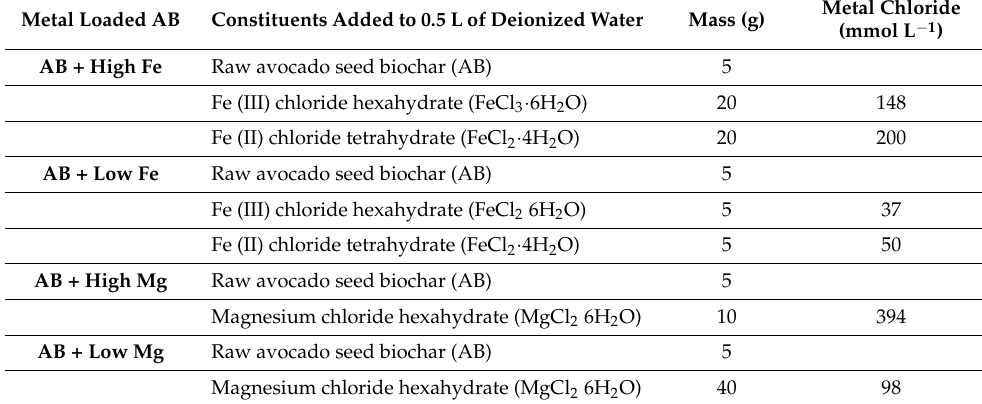
Table 1. Biochar and metal loadings for